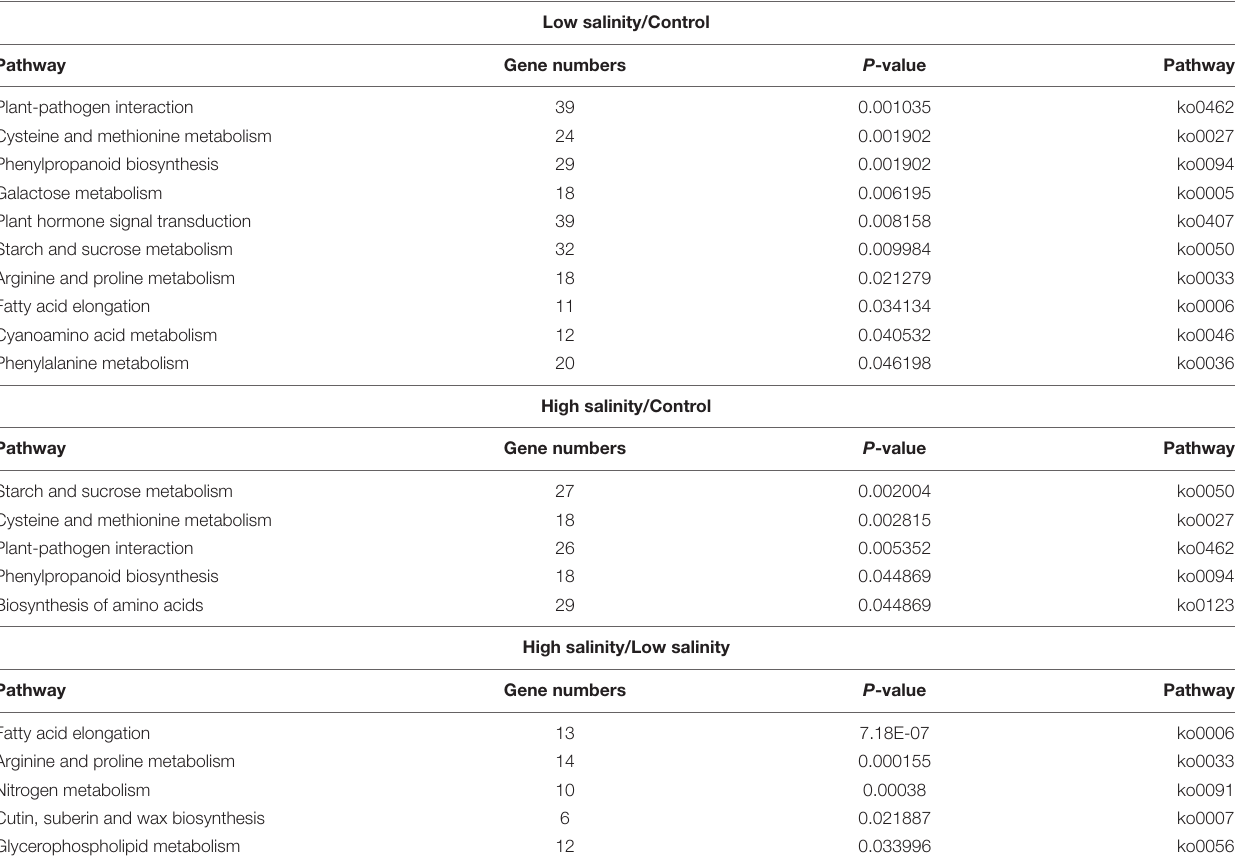
TABLE 4 | Metabolic pathway enrichment analysis of differentially expressed genes (DEGs) as identified by KEGG analyses in leaves of P. antidotale